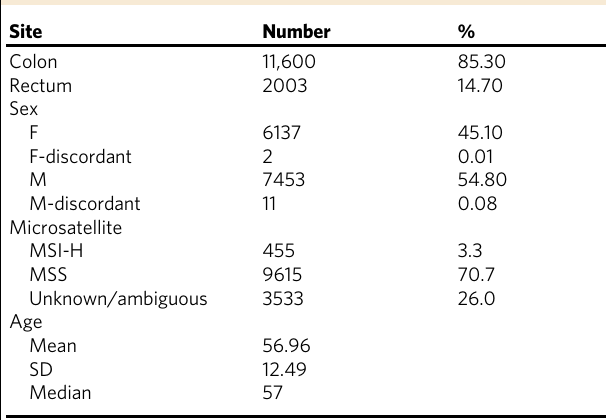
Table 1 Clinical characteristics of 13,336 colorectal cancer patients in